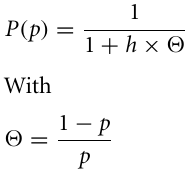
FIGURE 1 |Additive and. interactive models of value integration. Value was computed according to the bilinear model with x 1 = 1 and x 2 = 1. Additive models are depicted on the left, with x 3 = 0. Interactive models are depicted on the right, with x 3 = 0.06.Top panels employed a linear utility function for